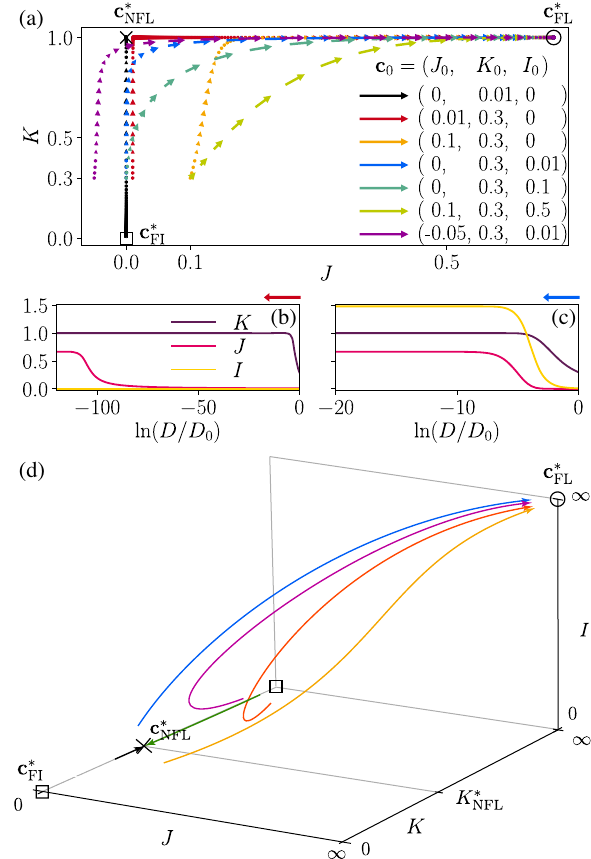
FIG. 1. (a) RG flow of the coupling vector c ¼ ð J; K; I Þ (projected into the J - K plane), obtained by solving the weak- coupling RG equations (2) [Eqs. (8) – (10) of Ref. [9] ] for various initial values, c 0 ¼ ð J 0 ; K 0 ; I 0 Þ . Arrows depict the gradient vector − ½ d= ð d ln D Þ(cid:2)ð J; K Þ at equal steps of ln D . (b),(c) Weak-coupling RG flow of c ð D Þ for (b) c 0 ¼ ð 0 . 01 ; 0 . 3 ; 0 Þ [red arrows in (a)] and (c) (0,0.3,0.01) [blue arrows in (a)]. (d) Qualitative depiction of the conjectured RG flow in the full J - K - I space, for all couplings non-negative. Fat, faint dashed lines show the solutions c ð D Þ of the weak-coupling equations (2), initialized at K K (cid:4) with ð J 0 ; I 0 Þ ¼ ð 0 ; 0 Þ (black), ð > 0 ; 0 ) (yellow), or ð 0 ; > 0 Þ NFL (blue), and plotted only in the weak-coupling regime [beyond the latter, Eqs. (2) lose validity]. Solid lines, drawn by hand, qualitatively show the flow expected beyond the weak-coupling regime, including trajectories initialized at K 0 ≫ K (cid:4) ð J 0 ; I 0 Þ ¼ ð 0 ; 0 Þ (green), ð > 0 ; 0 Þ (orange), or ð 0 ; > 0 Þ (purple). The black squares, cross, and circle depict fixed